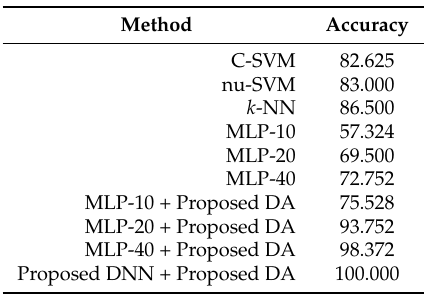
Table 5. Average accuracy (%)